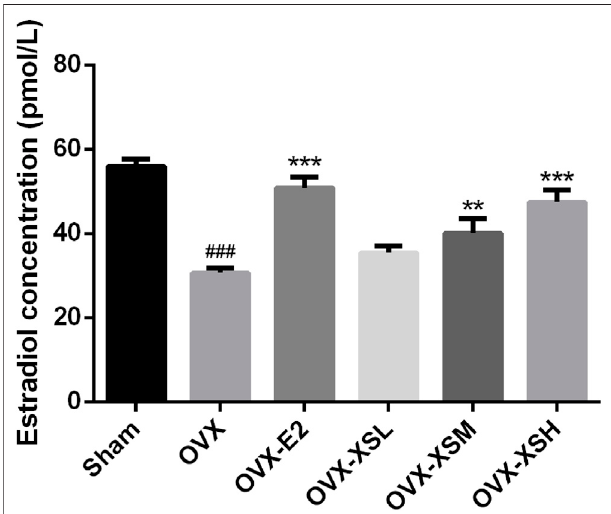
FIGURE 6 | Effects of XS volatile oil and estradiol treatment on serum estradiol levels in OVX rats. Data were represented as mean ± SEM; n (cid:2) 8 – 10 per group. OVX-E2 (estradiol valerate, 0.18 mg/kg), OVX-XSL (10.8 mg/kg), OVX-XSM (32.4 mg/kg), OVX-XSH (97.2 mg/kg). ### p < 0.001 compared with the sham group; ** p < 0.01, *** p < 0.001 compared with the OVX group.